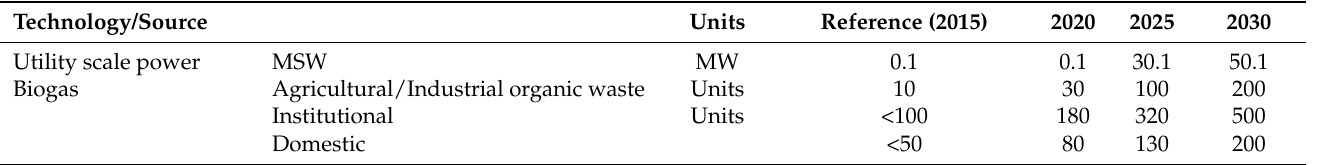
Table 1. REMP targets for WtE technologies in Ghana